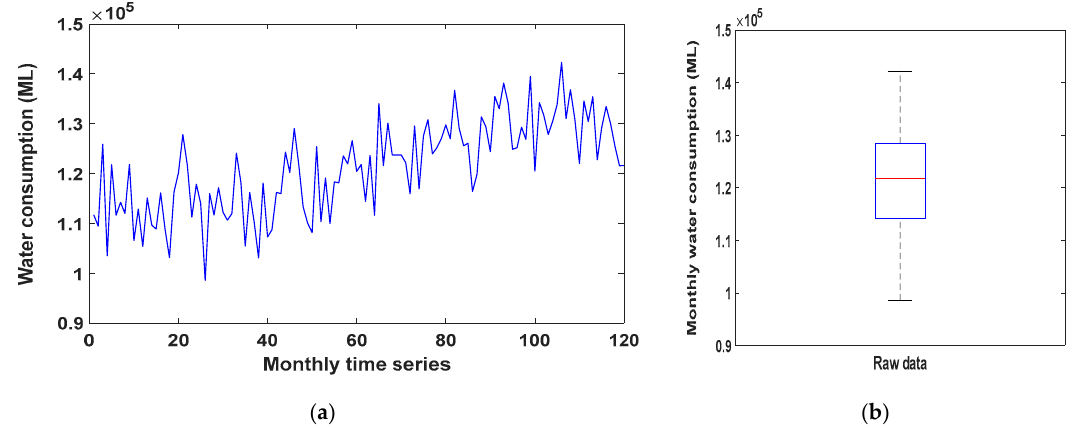
Figure 1. Municipal water consumption: ( a ) monthly time series, ( b ) boxplot for Rand Water Company.